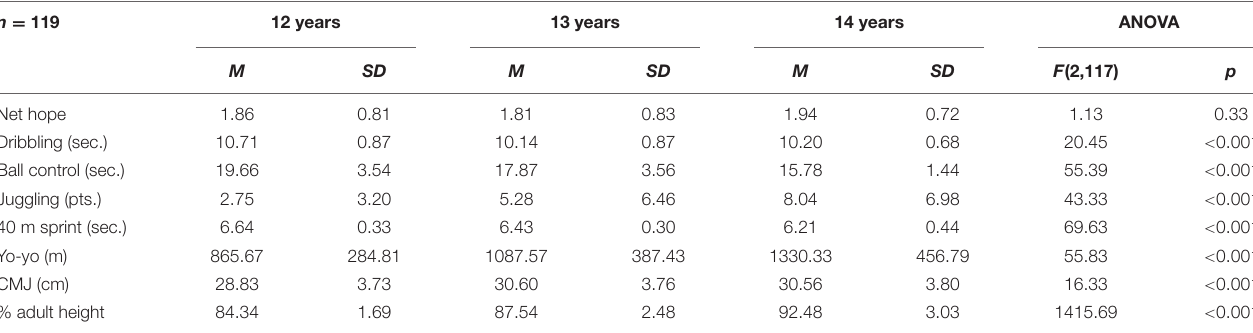
FIGURE 1 | z -score profiles of the clusters (cluster centroids) and developmental (anti-)types for the ages 12, 13 and 14, and the performance criterion at age 15. TABLE 1 | Descriptive statistics of the operating variables at the three measuring points and one-way repeated measures